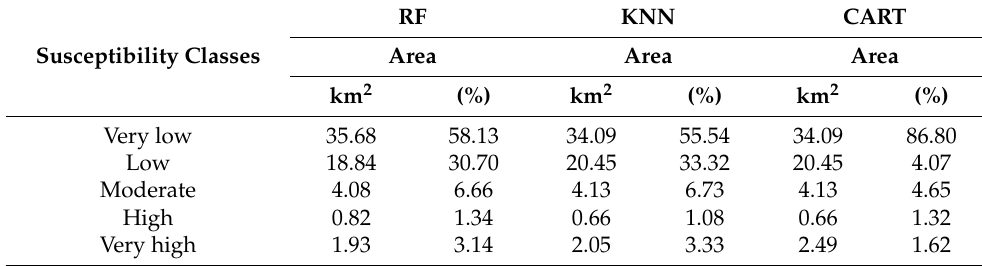
Table 2. Area of land subsidence (LS) susceptibility classes in various machine learning (ML) models: random forests (RF), k-nearest neighbors (KNN), and classification and regression trees